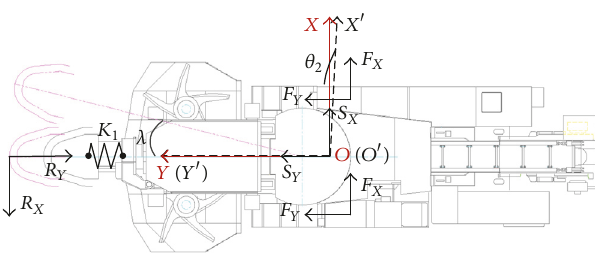
Figure 1: The coordinate system in vertical view of the overall machine.